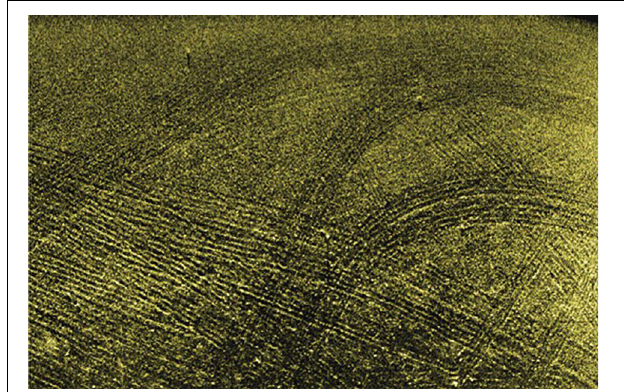
FIGURE 2 | Side-scan sonar images from within Lamlash Bay in 2004, indicating marks created by scallop dredges. Hardly any part of the seabed appears to have escaped